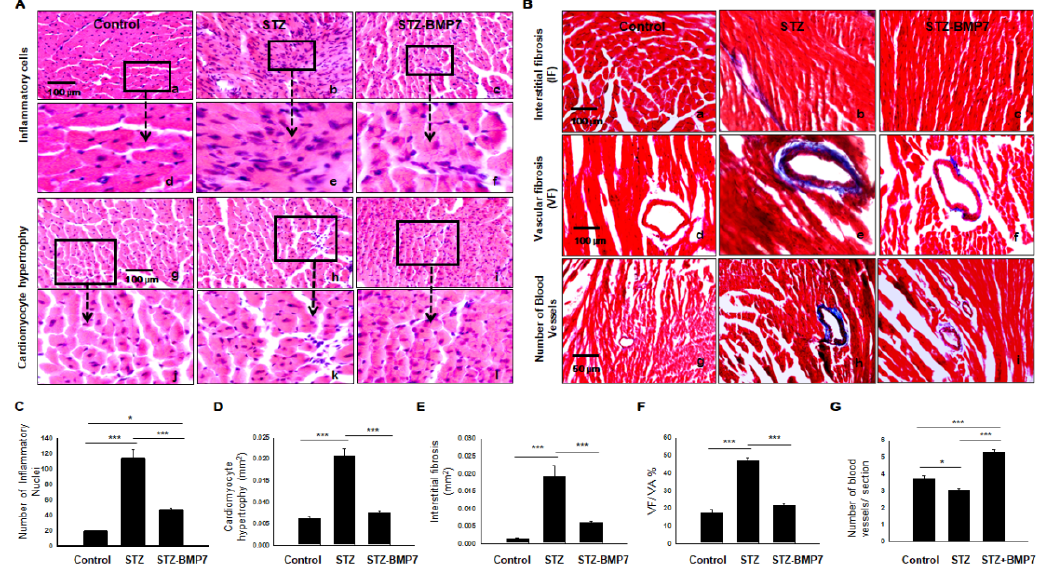
Figure 8. BMP-7 reduced cardiac infiltrated inflammatory cells, hypertrophy, interstitial, and vascular fibrosis in the diabetic heart. ( A ) Hematoxylin and Eosin staining (H&E) of heart sections showing inflammatory cells in images (a–c) and enlarged (d–f); hypertrophy in images (g–i) and enlarged (j–l) in all 3 groups. ( B ) Representative photomicrographs of Masson’s trichrome staining performed on heart sections to assess interstitial (a–c), vascular (d–f) fibrosis, and the number of blood vessels (g–i) in all 3 groups. ( C – G ) Quantitative analysis of the number of inflammatory cells ( C ) and cardiomyocyte cell diameter area (hypertrophy) ( D ), interstitial fibrosis ( E ), vascular fibrosis ( F ), and the number of blood vessels ( G ) in all groups. Statistical analysis was performed using One-Way ANOVA, which was followed by the Tukey test. Images taken at 40×; Error bars = mean ± S.E.M. * p < 0.05, *** p < 0.001; Scale bar = 100 µm; n = 16/group.